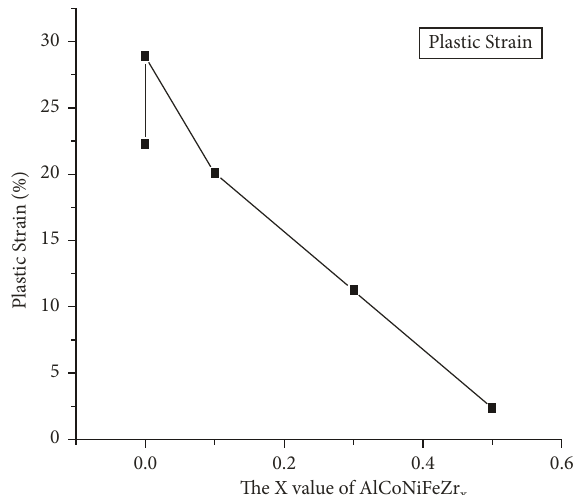
x alloys (com- Figure 9: Effect of Zr content on yield strength for the AlCoCr- FeNiZr x HEAs [12].